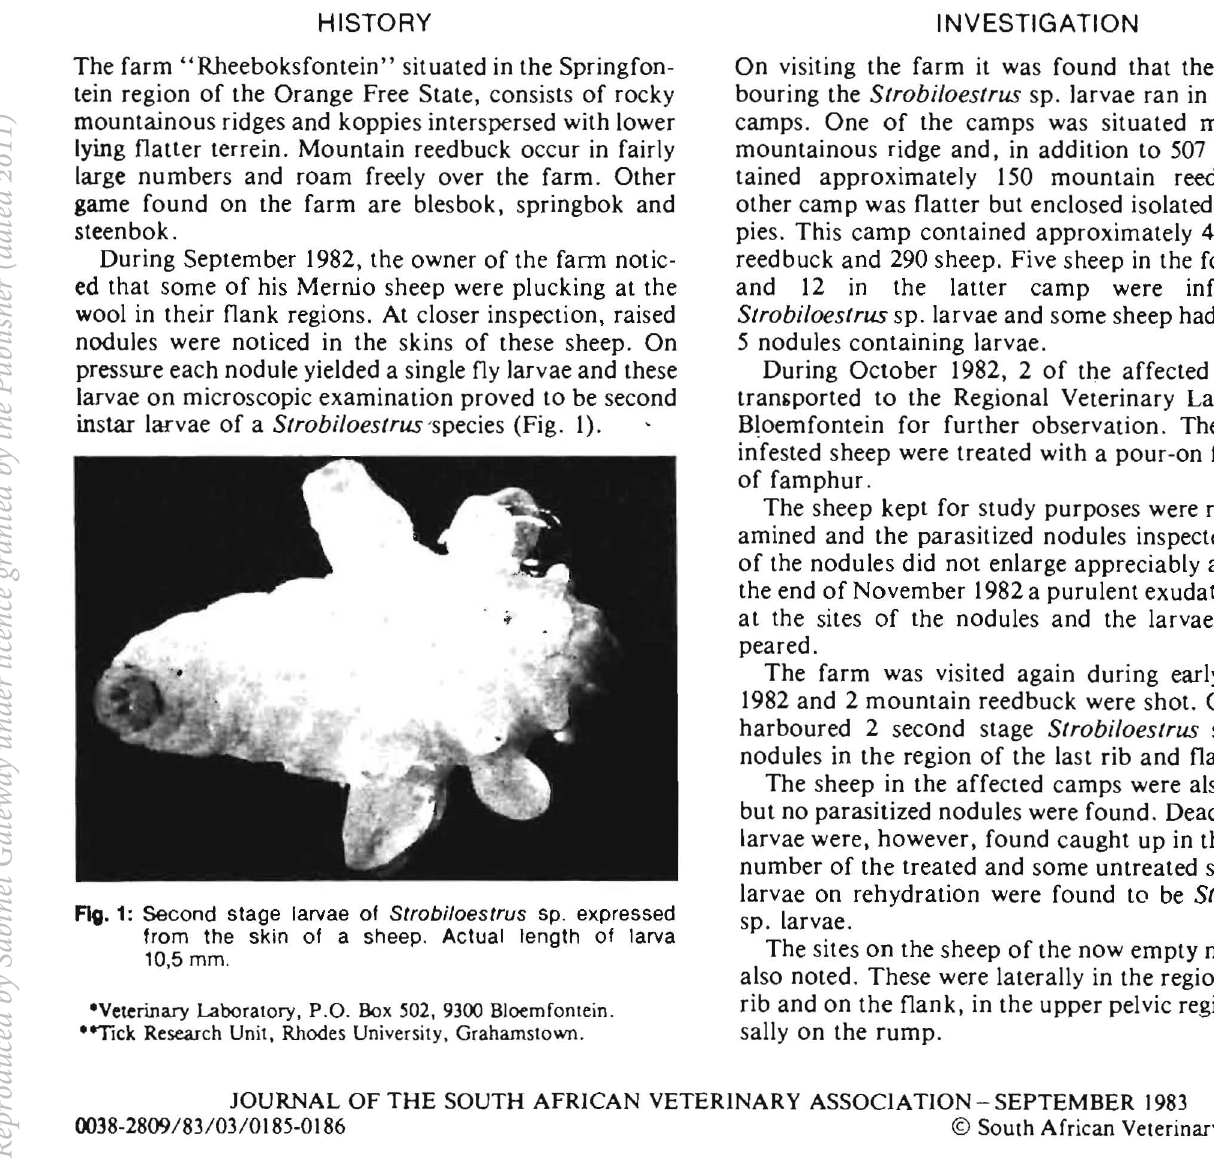
FiQ. 1: Second stage larvae of Strobiloestrus sp. expressed from the skin of a sheep. Actual length of larva 10,5